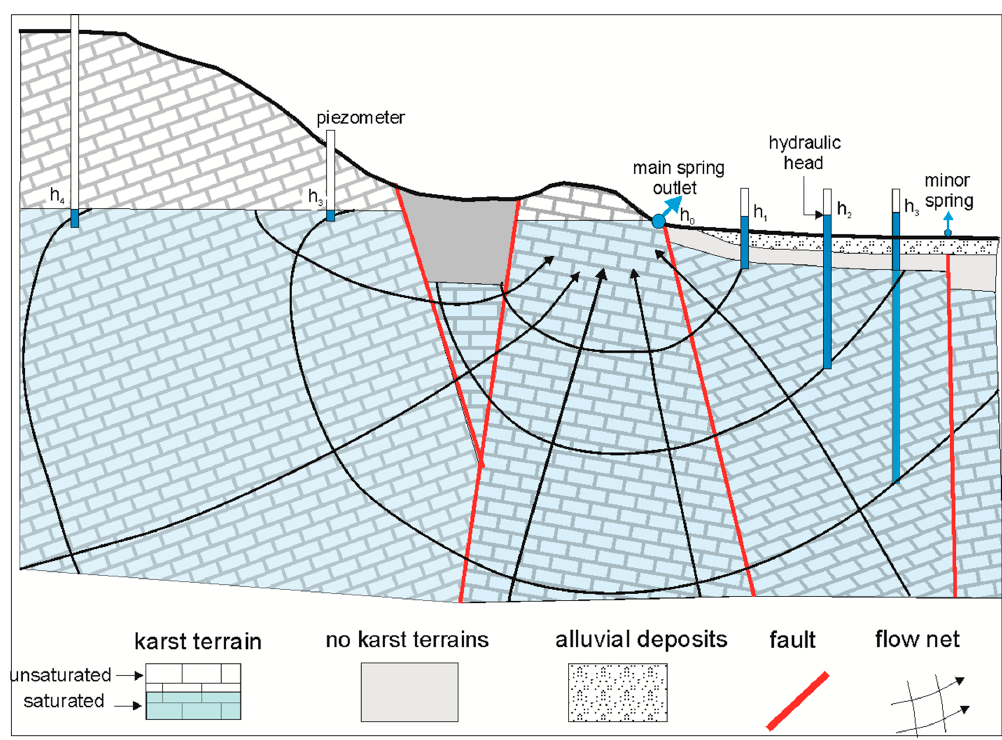
Figure 12. General sketch of the groundwater path (detail of Figure 1b), with flow net deducted from hydraulic heads detected into piezometers located upstream and downstream of the main spring outlet; recharge area is located on the left side.